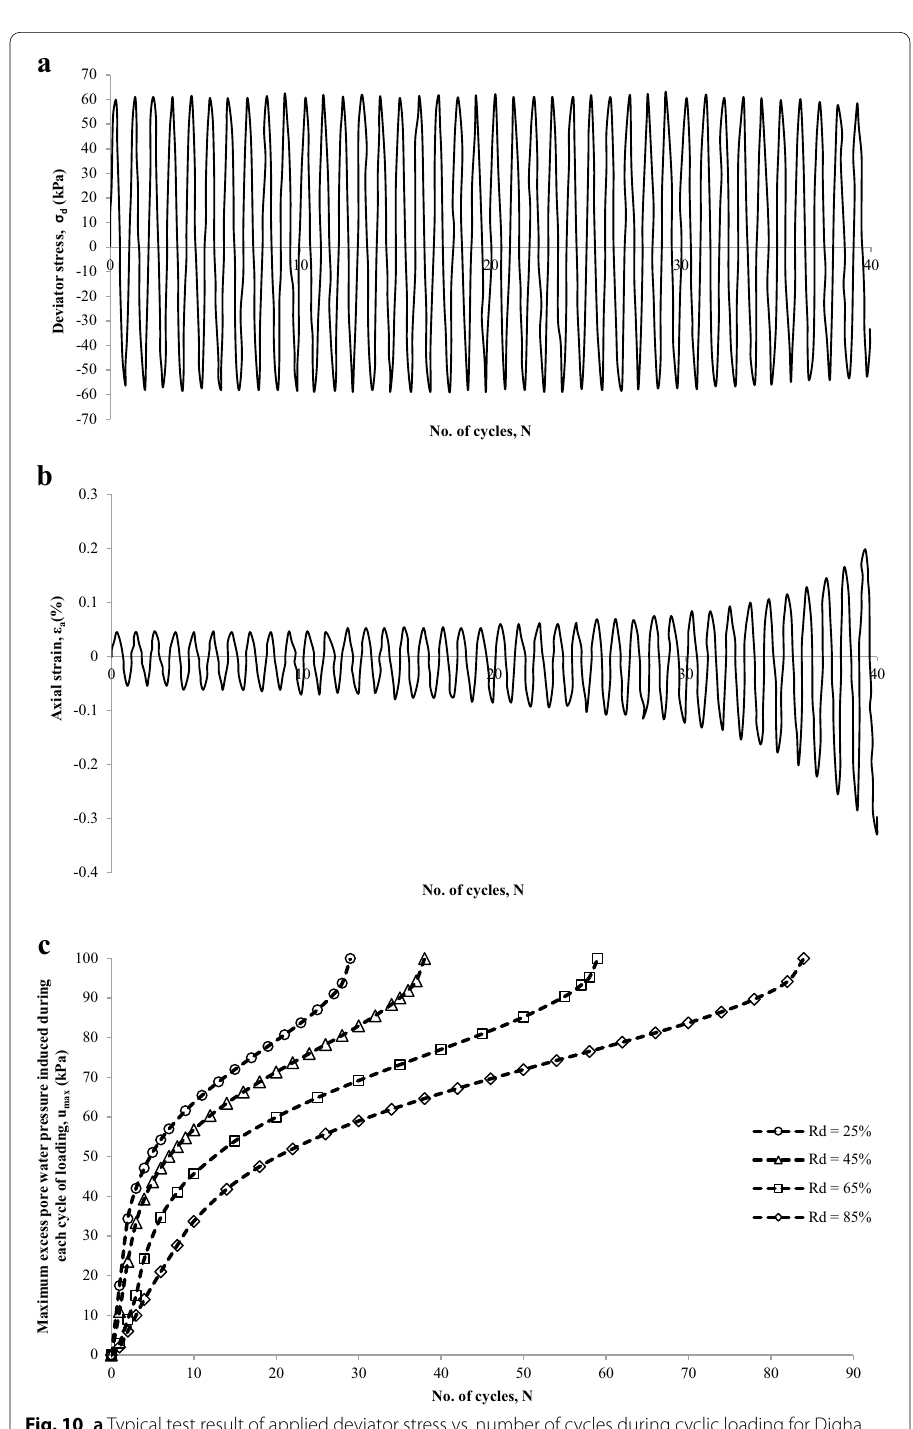
Fig. 10 a Typical test result of applied deviator stress vs. number of cycles during cyclic loading for Digha sand at R d 45%, σ o 100 kPa, applied CSR 0.3, f 1 Hz. b Typical test result of response of axial strain vs. = = = = number of cycles during cyclic loading for Digha sand at R d 45%, σ o 100 kPa, applied CSR 0.3, f 1 Hz. c = = = = Typical test result of generation maximum excess pore water pressure induced during each cycle of loading vs. number of loading cycles during cyclic triaxial test for Digha sand at constant σ o 100 kPa, constant = CSR 0.3, with variation of all relative densities i.e. 25 to =